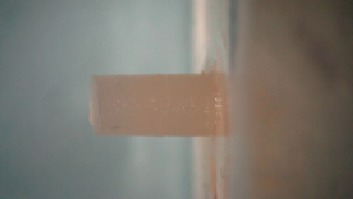
Specimen ready for shear strength test.